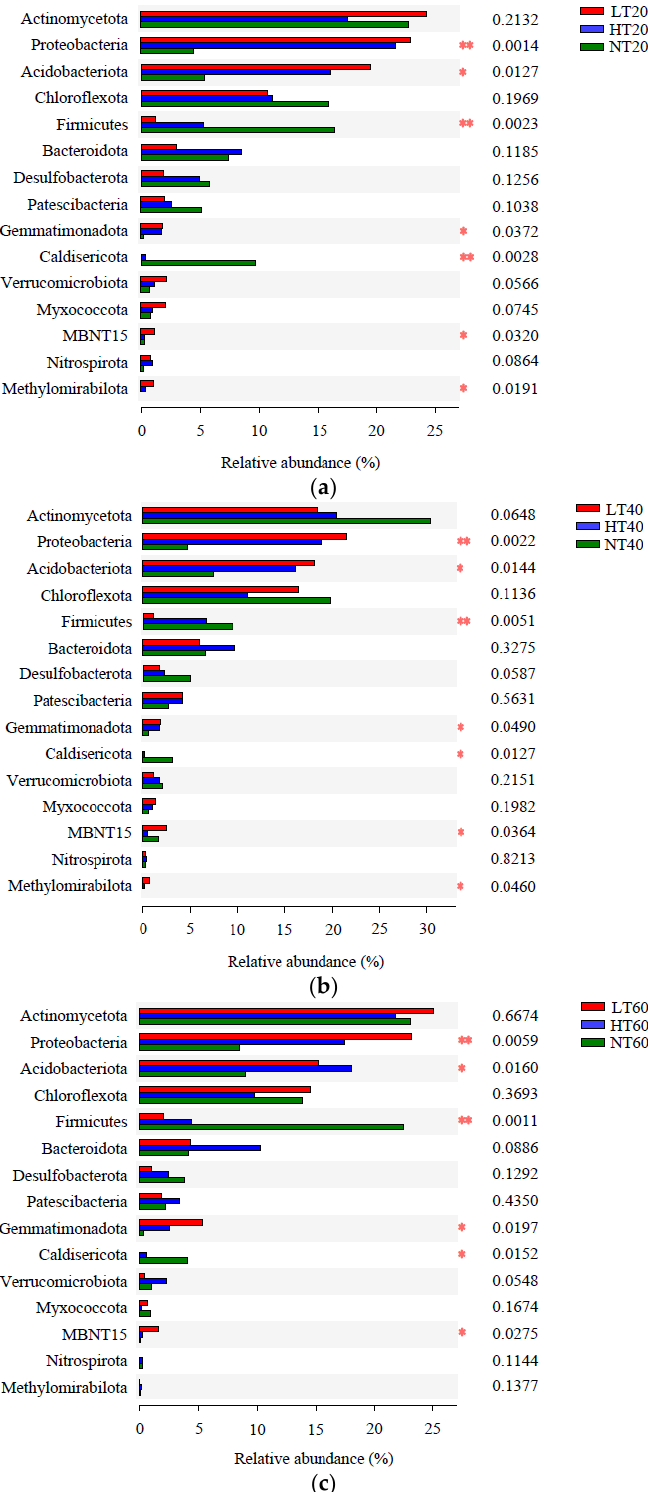
Figure 5. Analyses of significant differences in bacterial relative abundance at the phylum level between three peatlands at 0–20 ( a ), 20–40 ( b ), and 40–60 ( c ) cm depths. * means significant at p < 0.05, ** means significant at p < 0.01.